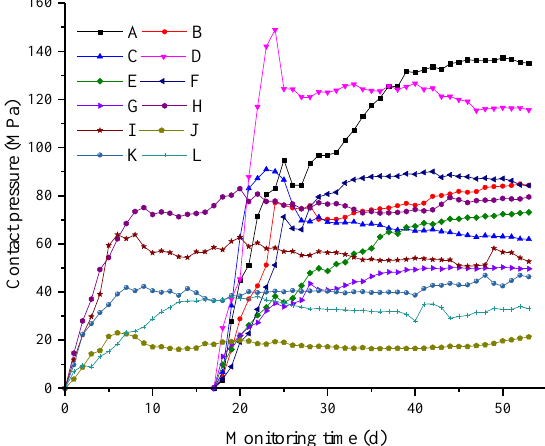
Figure 23. Time history plots of the contact pressures between the primary and secondary supports.